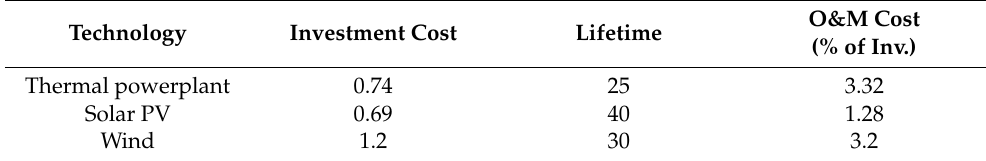
Table 3. Cost details for different power generation technologies